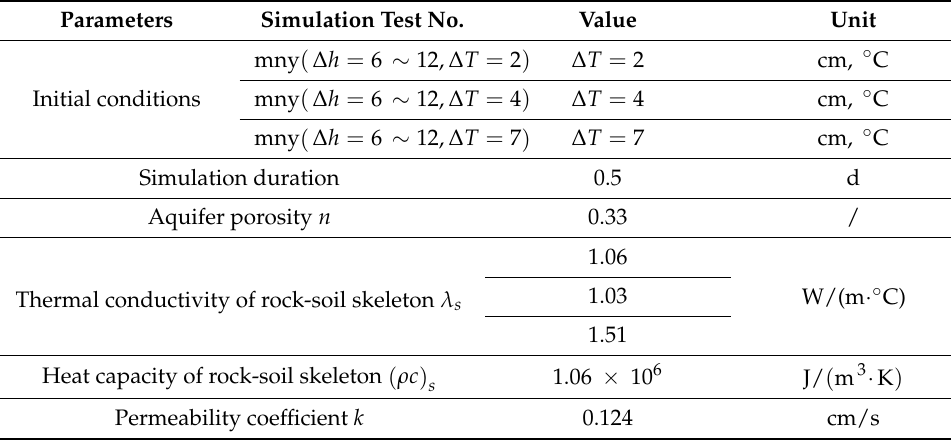
Table 6. Simulation parameter settings in the case of u (cid:54) = 0. Parameters Simulation Test